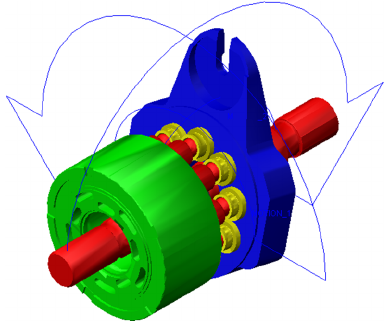
Figure 3. Dynamic model of the pump.